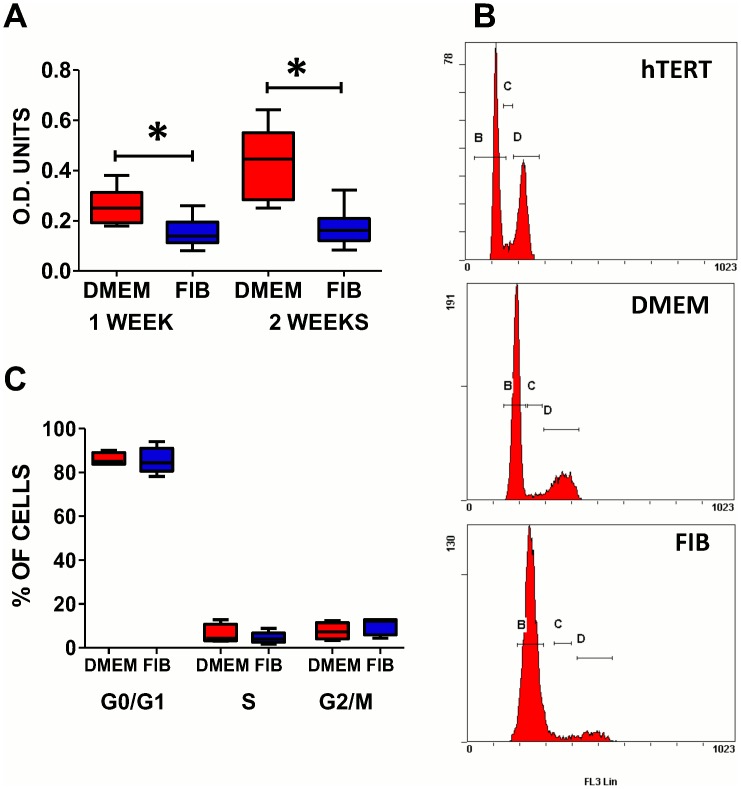

Graph showing the proliferation of VICs in DMEM and FIB at 1 and 2 weeks (A). FACS histograms showing cell cycle analysis in hTert cells (positive control), DMEM and FIB treated cells (B) and graph showing the median levels of cells in the different phases of the cell cycle (C). Data labelled as FIB is from VICs that were switched to fibroblast media for 2 weeks prior to analysis.